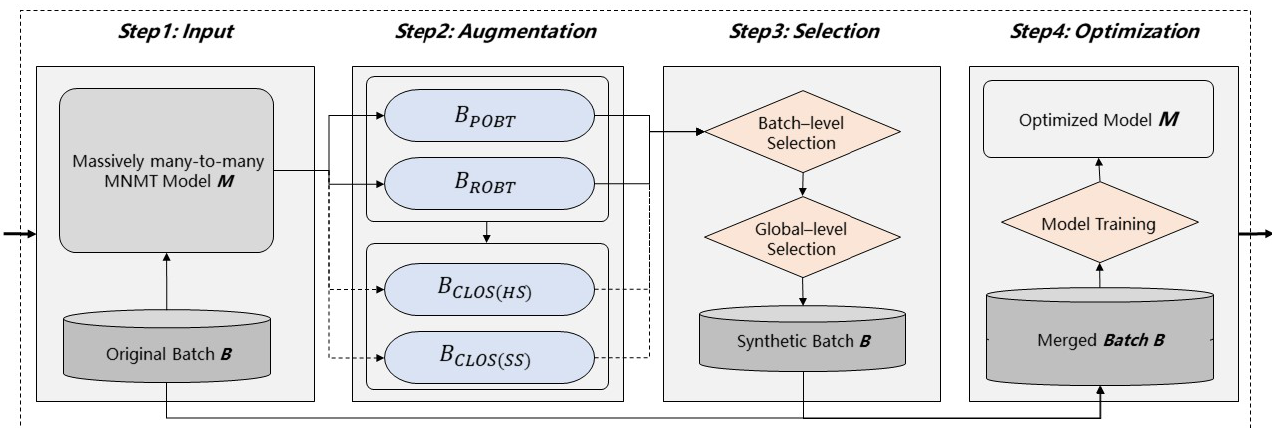
Figure 3. One update in the augmentation and substitution fine-tuning stages. The dash arrows in the augmentation step mean that CLOS(HS) and CLOS(SS) are only optional in the substitution fine-tuning